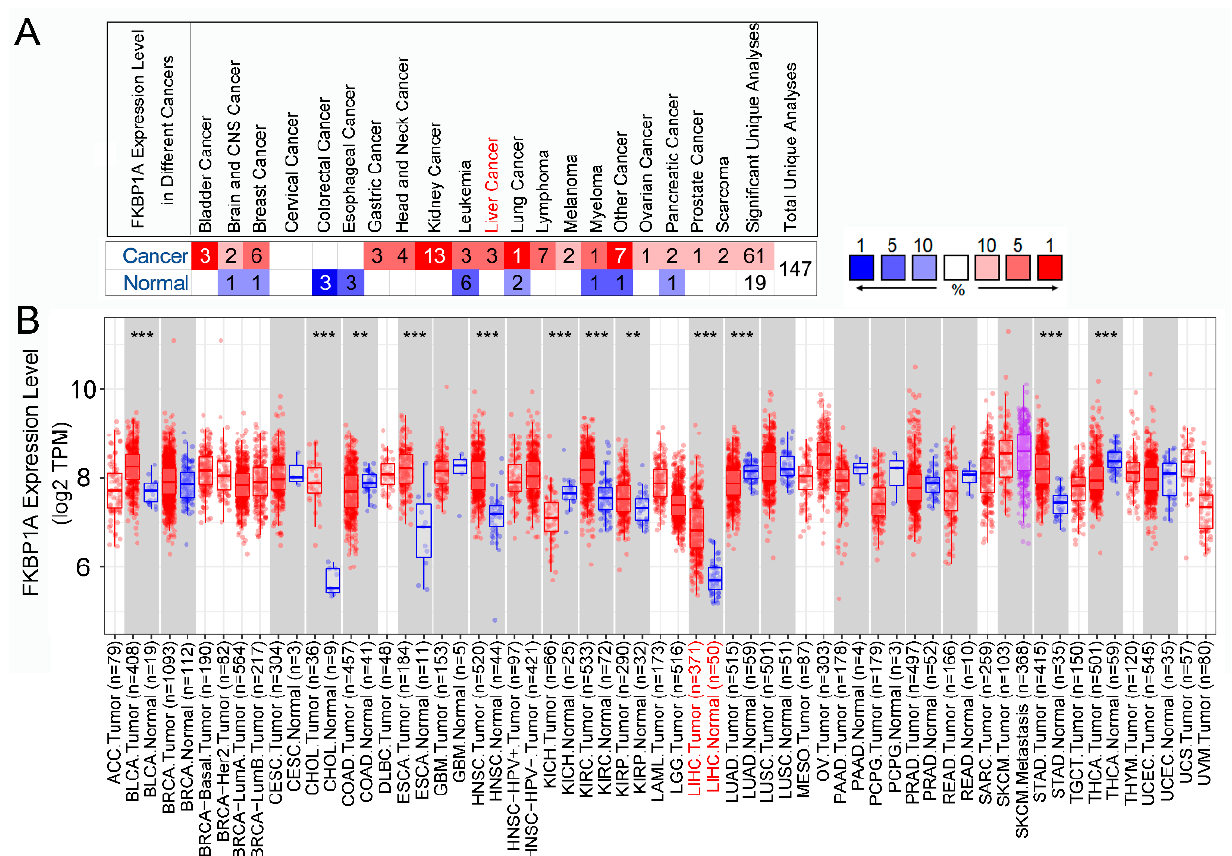
Figure 1. The FKBP1A expression levels in various types of cancer tissues indicated by mRNA detection. ( A ) The expression level of FKBP1A in different types of tumor tissues and normal tissues in the Oncomine database. Number listed under name of each tumor is sample number ( n ) recorded in each dataset. Red highlight indicates high expression and blue indicates low expression. Darker red or darker blue represents higher or lower expression, respectively. ( B ) The expression levels of FKBP1A in different types of tumor tissues queried from the TCGA Oncomine tumor database and normal tissues via TIMER2.0 database analysis. ** p < 0.01, *** p < 0.001. Using UALCAN databases, we further examined the relationship between the FKBP1A expression levels and the lymph node metastasis. The analysis showed that the expression of FKBP1A was significantly increased in N0 (no regional lymph node metastasis, p < 0.0001, Figure 2D) and N1 (metastases in 1 to 3 axillary lymph nodes, p < 0.01, Figure 2D). Taken together, these results suggest that higher FKBP1A expression is broadly associated with the development of LIHC along with metastasis into lymph nodes. We would like to claim that the upregulated FKBP1A expression in LIHC might act as a potential diagnostic indicator for detecting LIHC